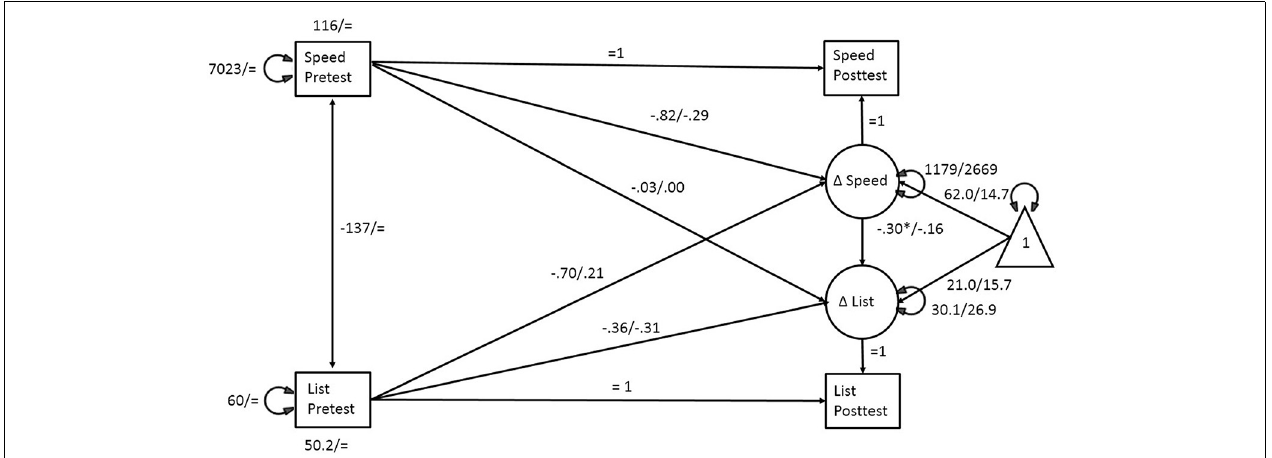
FIGURE 1 | Structural Equation Model to test for Transfer between Trained and Untrained Scores. Improvement in speeded discrimination after training is associated with RBANS list recall factor score improvement. Values for the experimental group/control group. Unstandardized values are